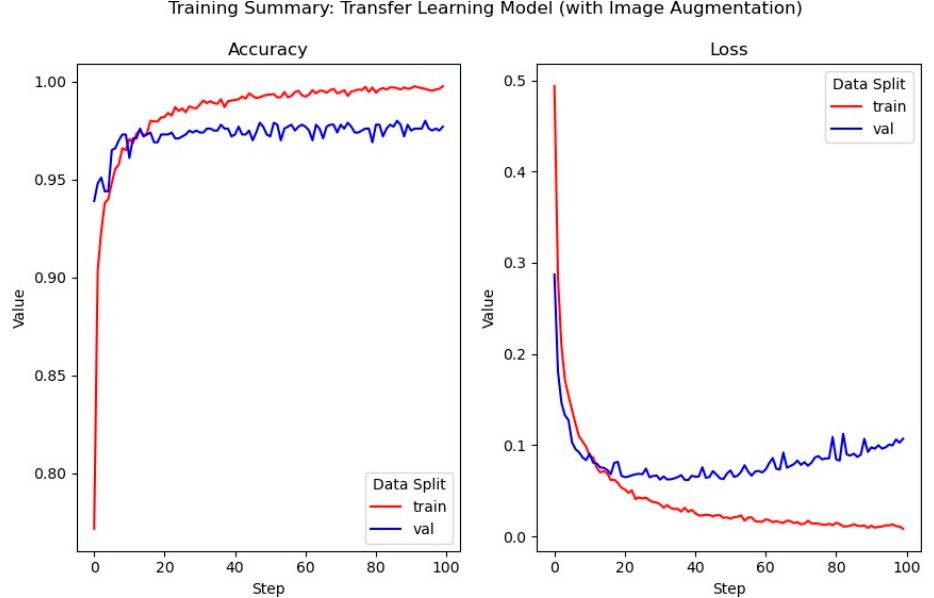
Figure 11. Training summary of the VGG-16 transfer learning model with image augmentation.